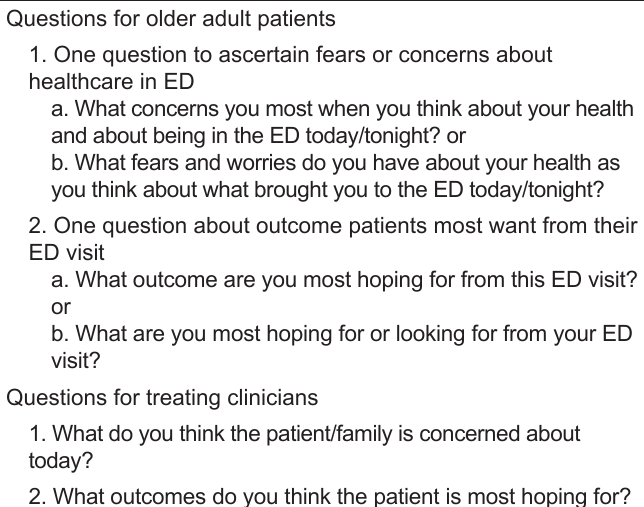
Table 1. ”‘What Matters” semi-structured interview guide for older adult patients and their treating